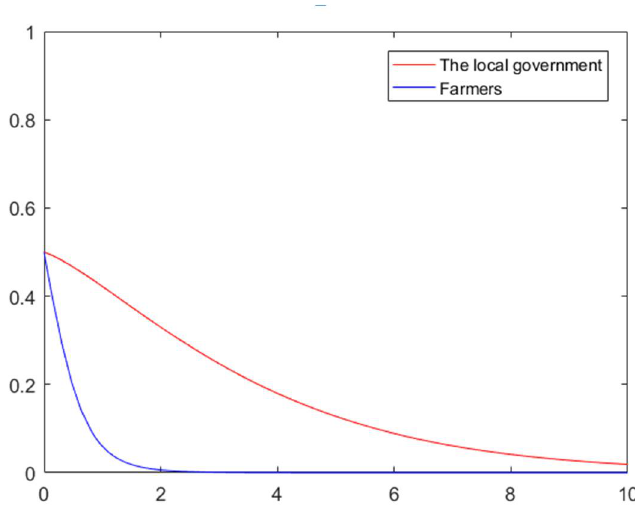
Figure 3. Simulation results under litigation settlement (C 2 = 4 ) .